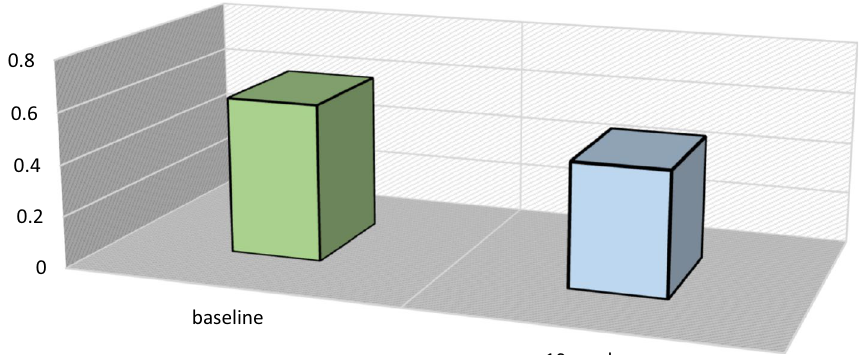
Figure 1. BCVA changes after biofeedback.